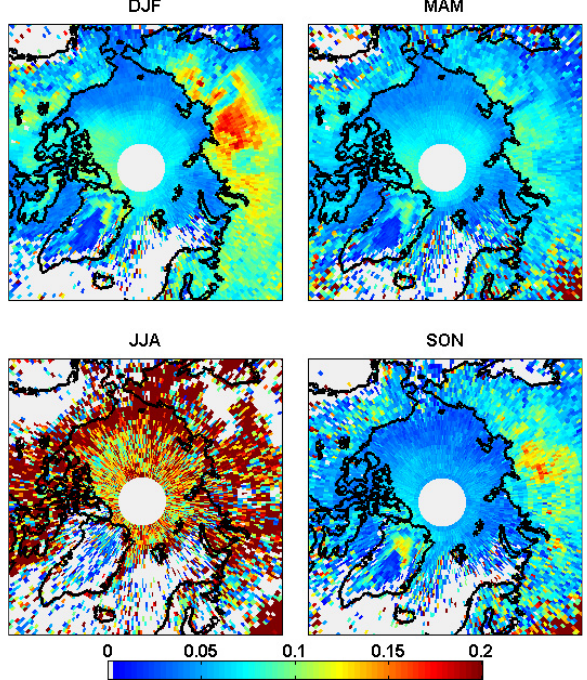
Fig. 4. Median water-vapour inversion strength (in gkg − 1 ) and its